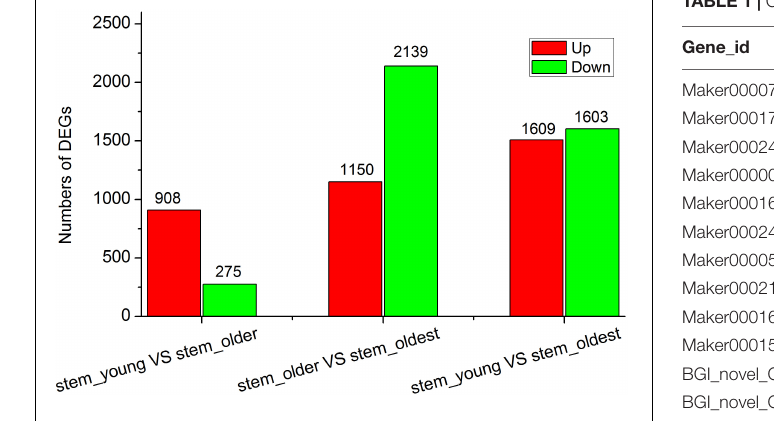
TABLE 1 | Candidates in the flavonoid biosynthesis of E. phaseoloides